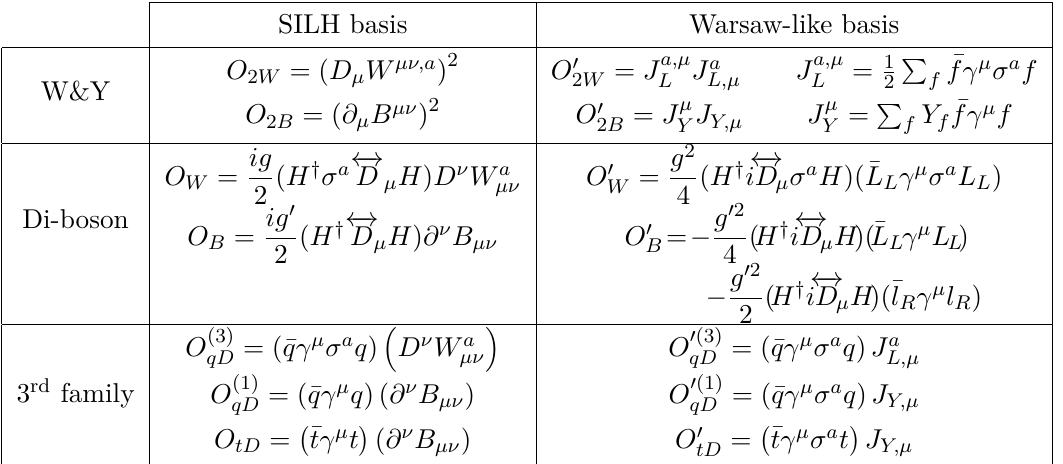
Table 2. The operators under consideration in their “SILH” [77] form and, after using the equations of motion, expressed as a linear combination of Warsaw [78] operators. Y the fermionic field f . In the operators involving the 3 rd family the fields t and q denote respectively the right-handed and left-handed top quark.